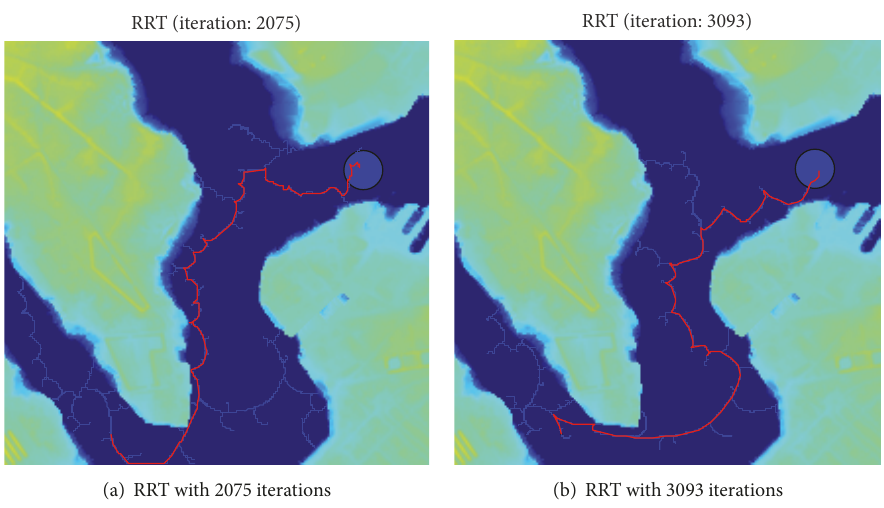
Figure 8: Planning with the same conditions by RRT. Start position locates at 157 ∘ 58 󸀠 30 󸀠󸀠 W, 21 ∘ 20 󸀠 29 󸀠󸀠 N; Goal locates at 157 ∘ 57 󸀠 47 󸀠󸀠 W, 21 ∘ 21 󸀠 14 󸀠󸀠 N, shown as a solid blue circle. Red line describes a valid path from start to